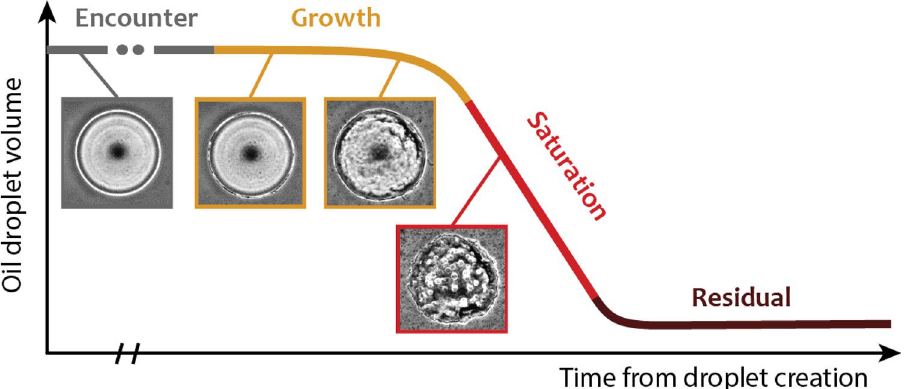
Figure 1. Schematic of the life of an oil droplet. The microbial degradation of an oil droplet is divided into four stages (time not to scale). During the initial encounter stage, the droplet does not have attached oil-degrading bacteria. After the first bacterial attachment, bacterial growth occurs until the available surface area is covered, inducing a transition to the saturation stage and linear degradation. In the final, residual stage, a non-zero volume can remain (non-metabolizable components). The insets are illustrative images of the stages taken from experiments using phase contrast time-lapse microscopy of an oil-degrading bacteria encountering and consuming a 100 µm diameter crude oil